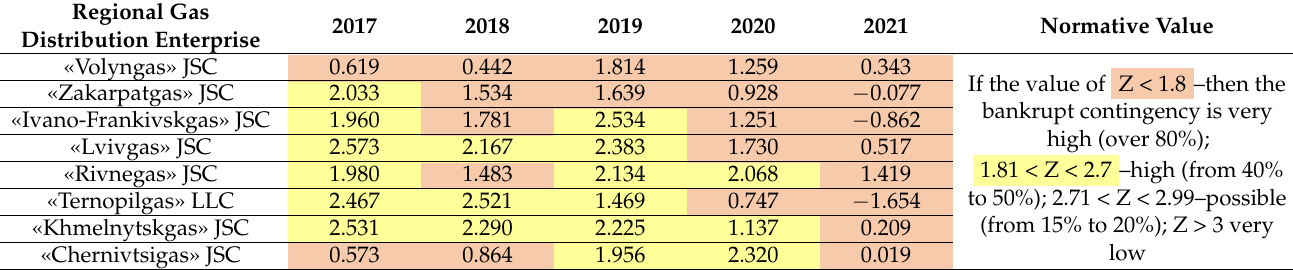
Table 5. Altman’s five-factor model